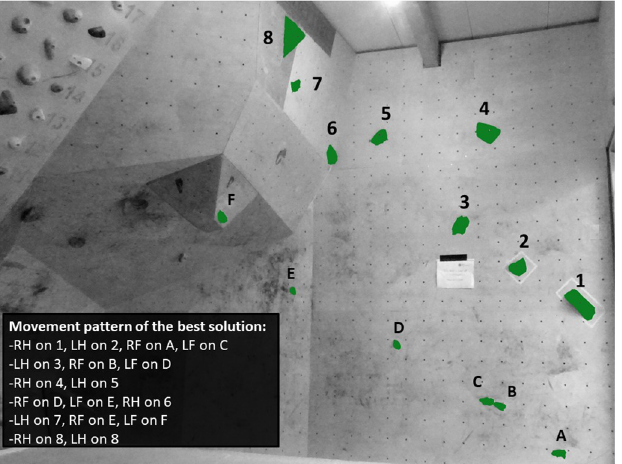
Fig 2. The bouldering task in Experiment 1 (RH: Right hand; LH: Left hand; RF: Right foot; LF: Left foot). Two handholds marked the starting position (i.e., handhold number 1 and 2) and the last hold (i.e., handhold number 8) marked the top. The experts’ best solution is displayed in the movement